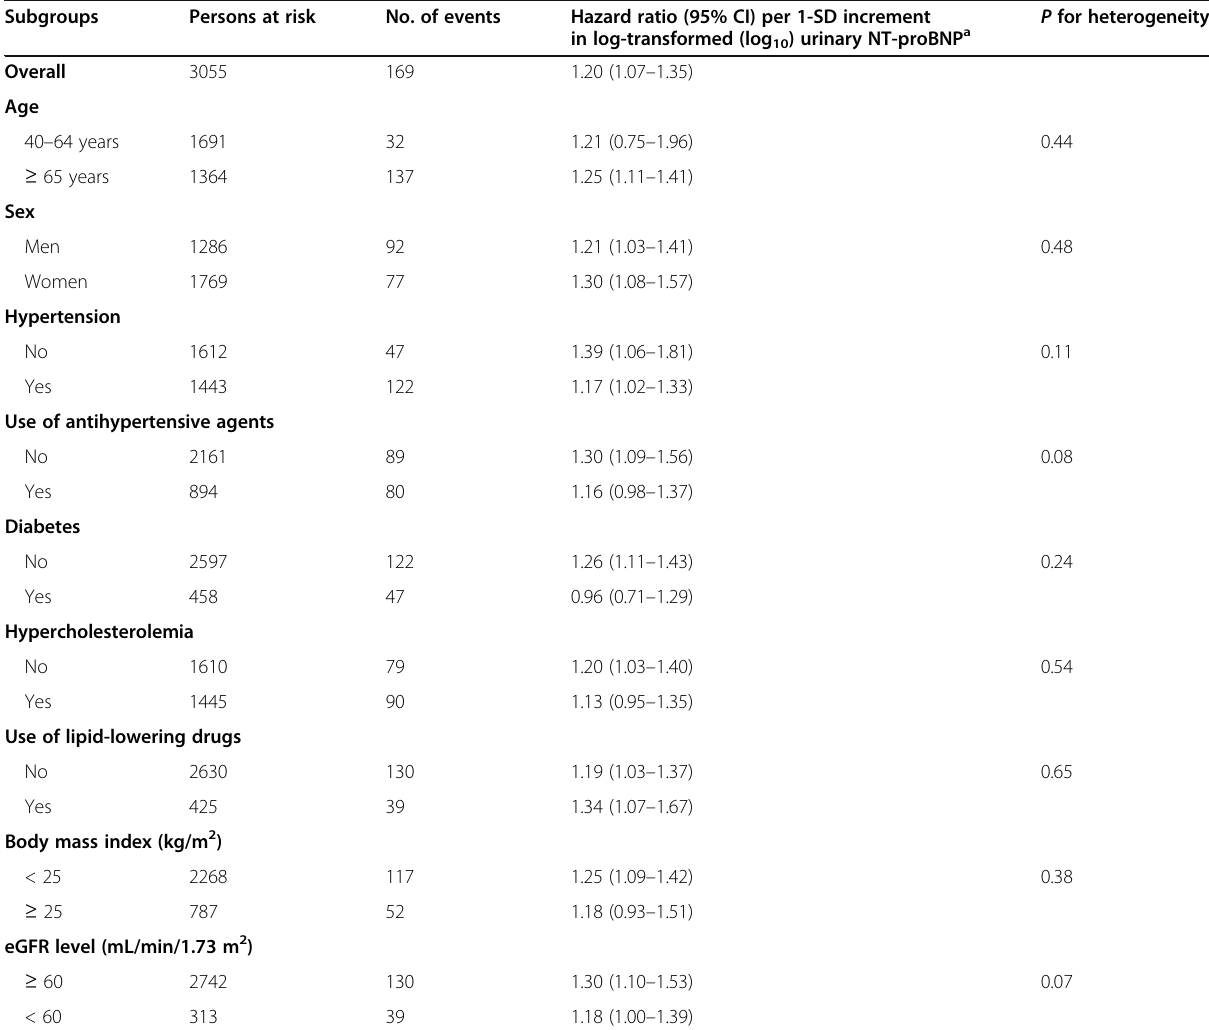
Table 3 Multivariable-adjusted hazard ratios of the log-transformed urinary NT-proBNP for the development of cardiovascular disease, stratified by presence or absence of traditional cardiovascular risk factors